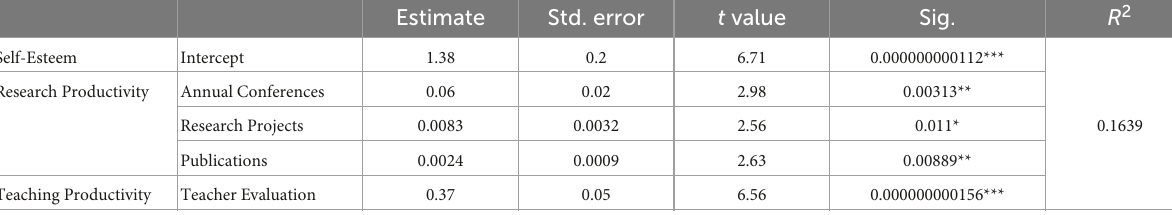
TABLE 5 Linear regression